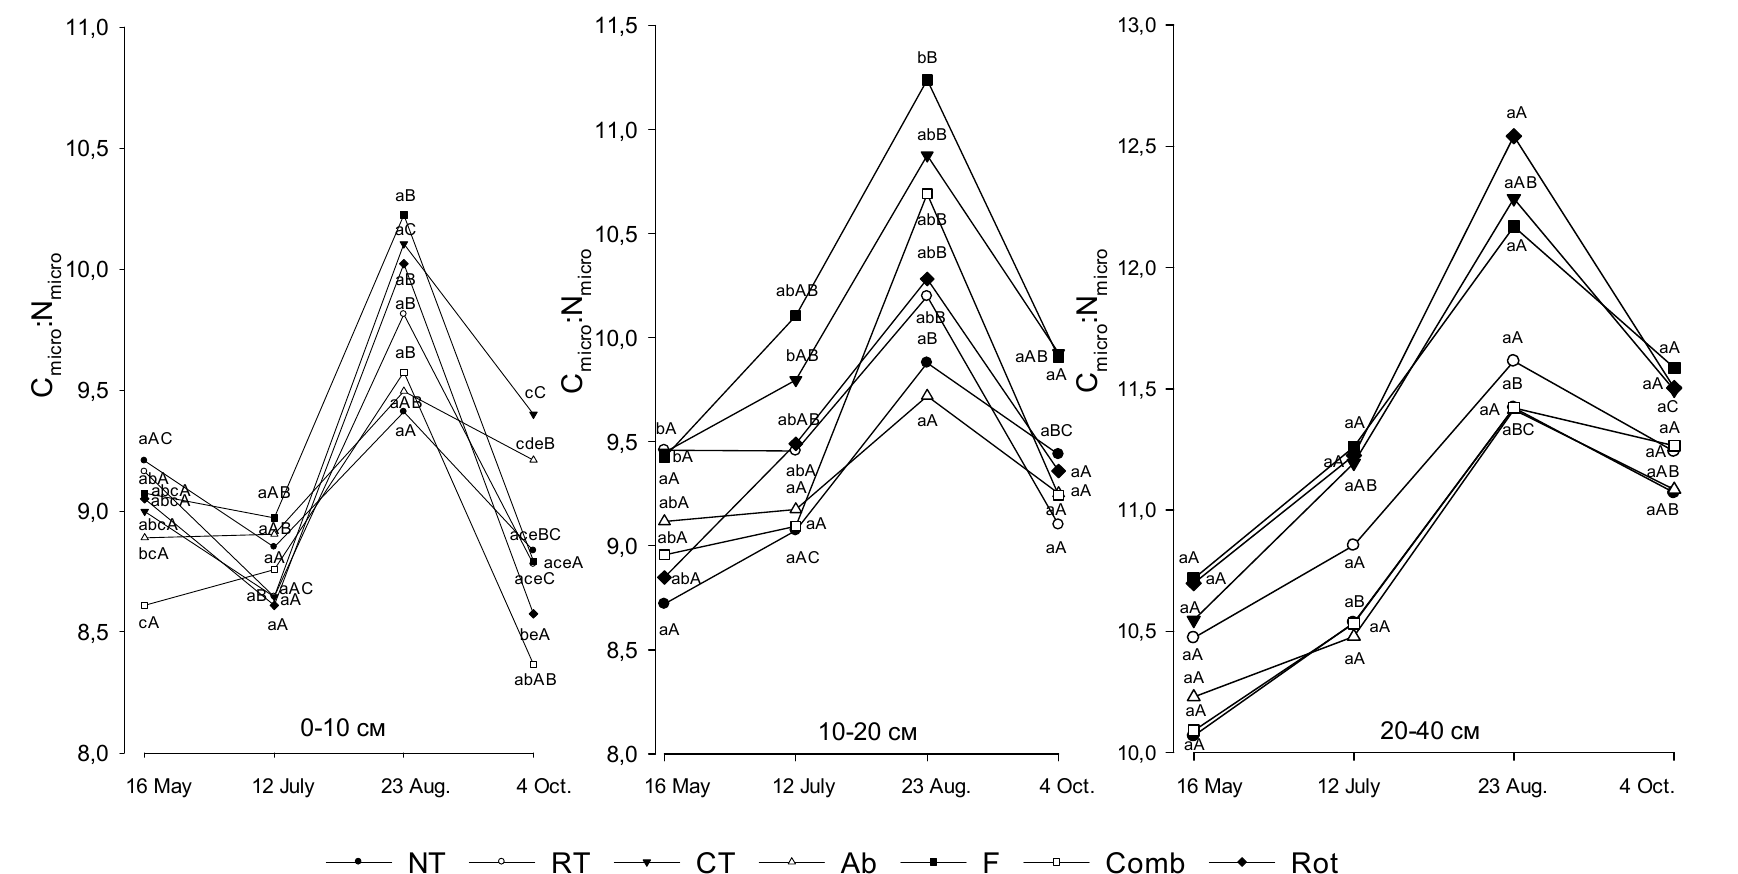
Figure 4. Seasonal dynamics of C micro :N micro in different Mollisol layers after 9 years of use: conservation tillage (CT), no till (NT), rotary (Rot), reduced (ridge) tillage (RT), combined (Comb) tillage, fallow (F, 22 years) and abandoned field (Ab, 22 years). Average values with different lowercase letters indicate a significant difference between tillage options, and uppercase letters are a significant difference between the selection periods (HIP, α = 0.05).